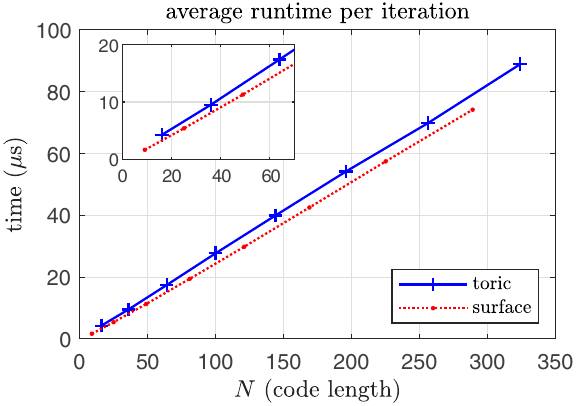
Fig. 7 Almost linear runtime of MBP 4 . The average runtime of MBP 4 on each toric or surface code is plotted.